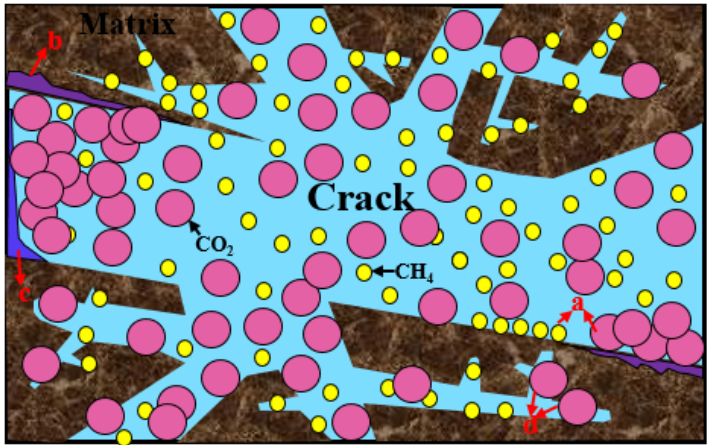
Figure 4. Schematic figure showing the mechanisms of CO 2 storage in shale (a) adsorption trapping; (b) mineralized trapping; (c) dissolved trapping; (d) residual trapping). (b) mineralized trapping; (c) dissolved trapping; (d) residual